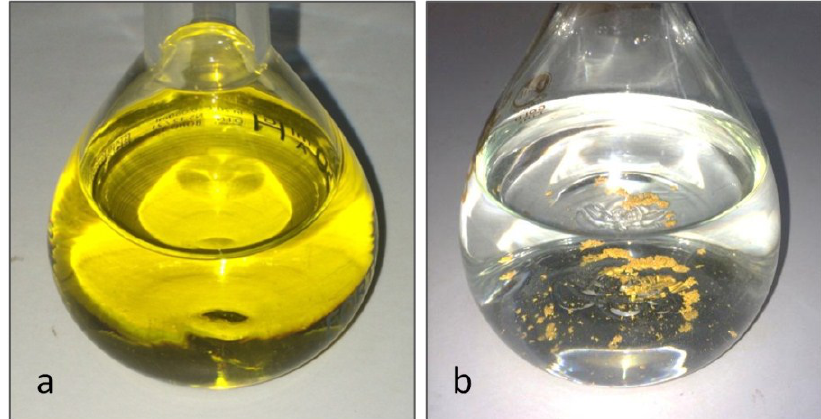
Figure 4. Photographs of gold(III) chloride solutions prepared by: ( a ) chlorine gas method; and ( b ) sodium hypochlorite/hydrochloric acid method (where precipitation occurred ~2 weeks